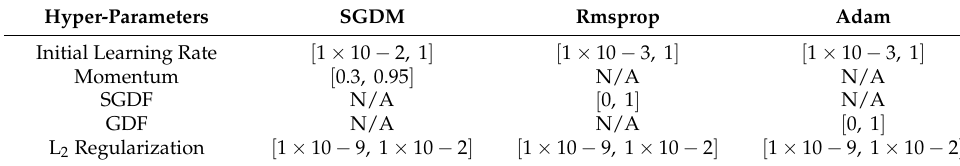
Table 6. Results of various combination of deep learning network structures and data balance meth- ods.